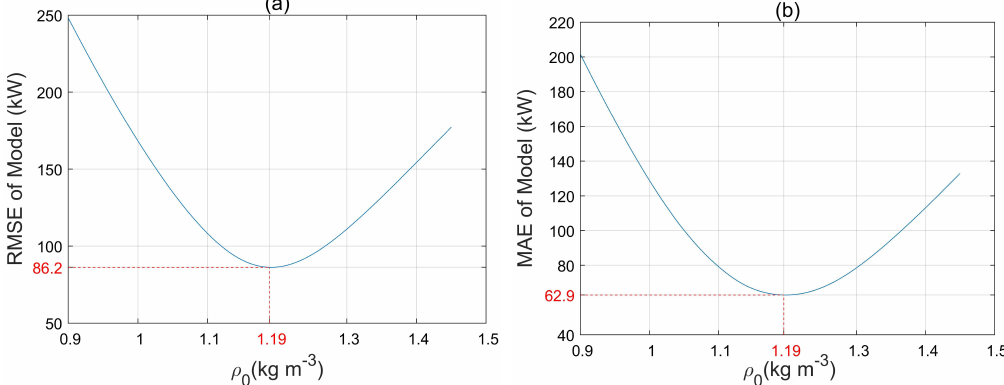
Figure 11. The effect of reference density on: ( a ) RMSE of the model; and ( b ) MAE of the